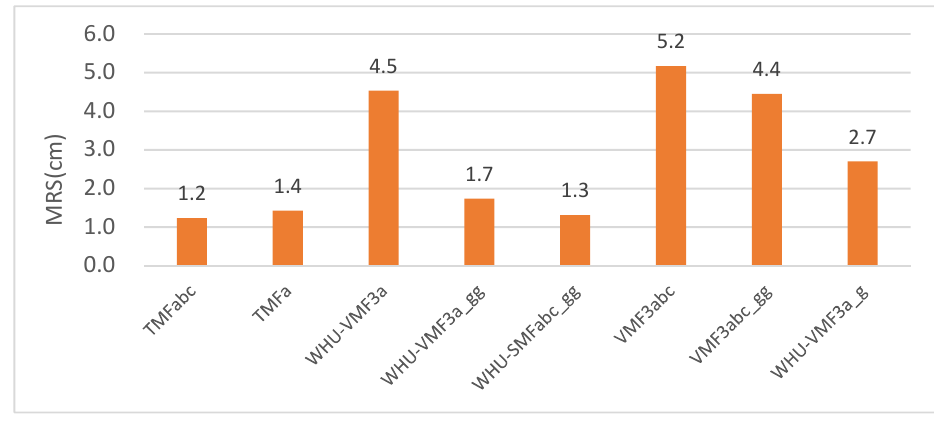
Figure 11. The RMS scatters of MF-derived total delays at the 5° elevation angle (units: cm).